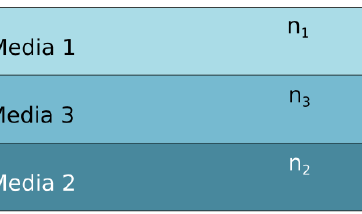
Figure 3. Lifshitz model implementation through three different materials, using the refractive index (n) and the permittivity ( (cid:101) ) as key features.